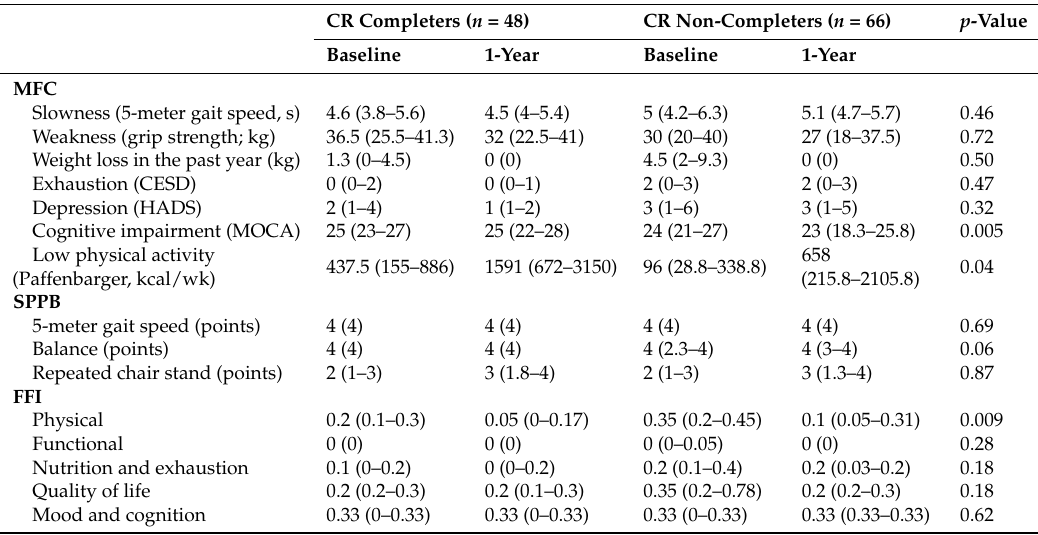
Table 3. Change in frailty domains between baseline and 1-year